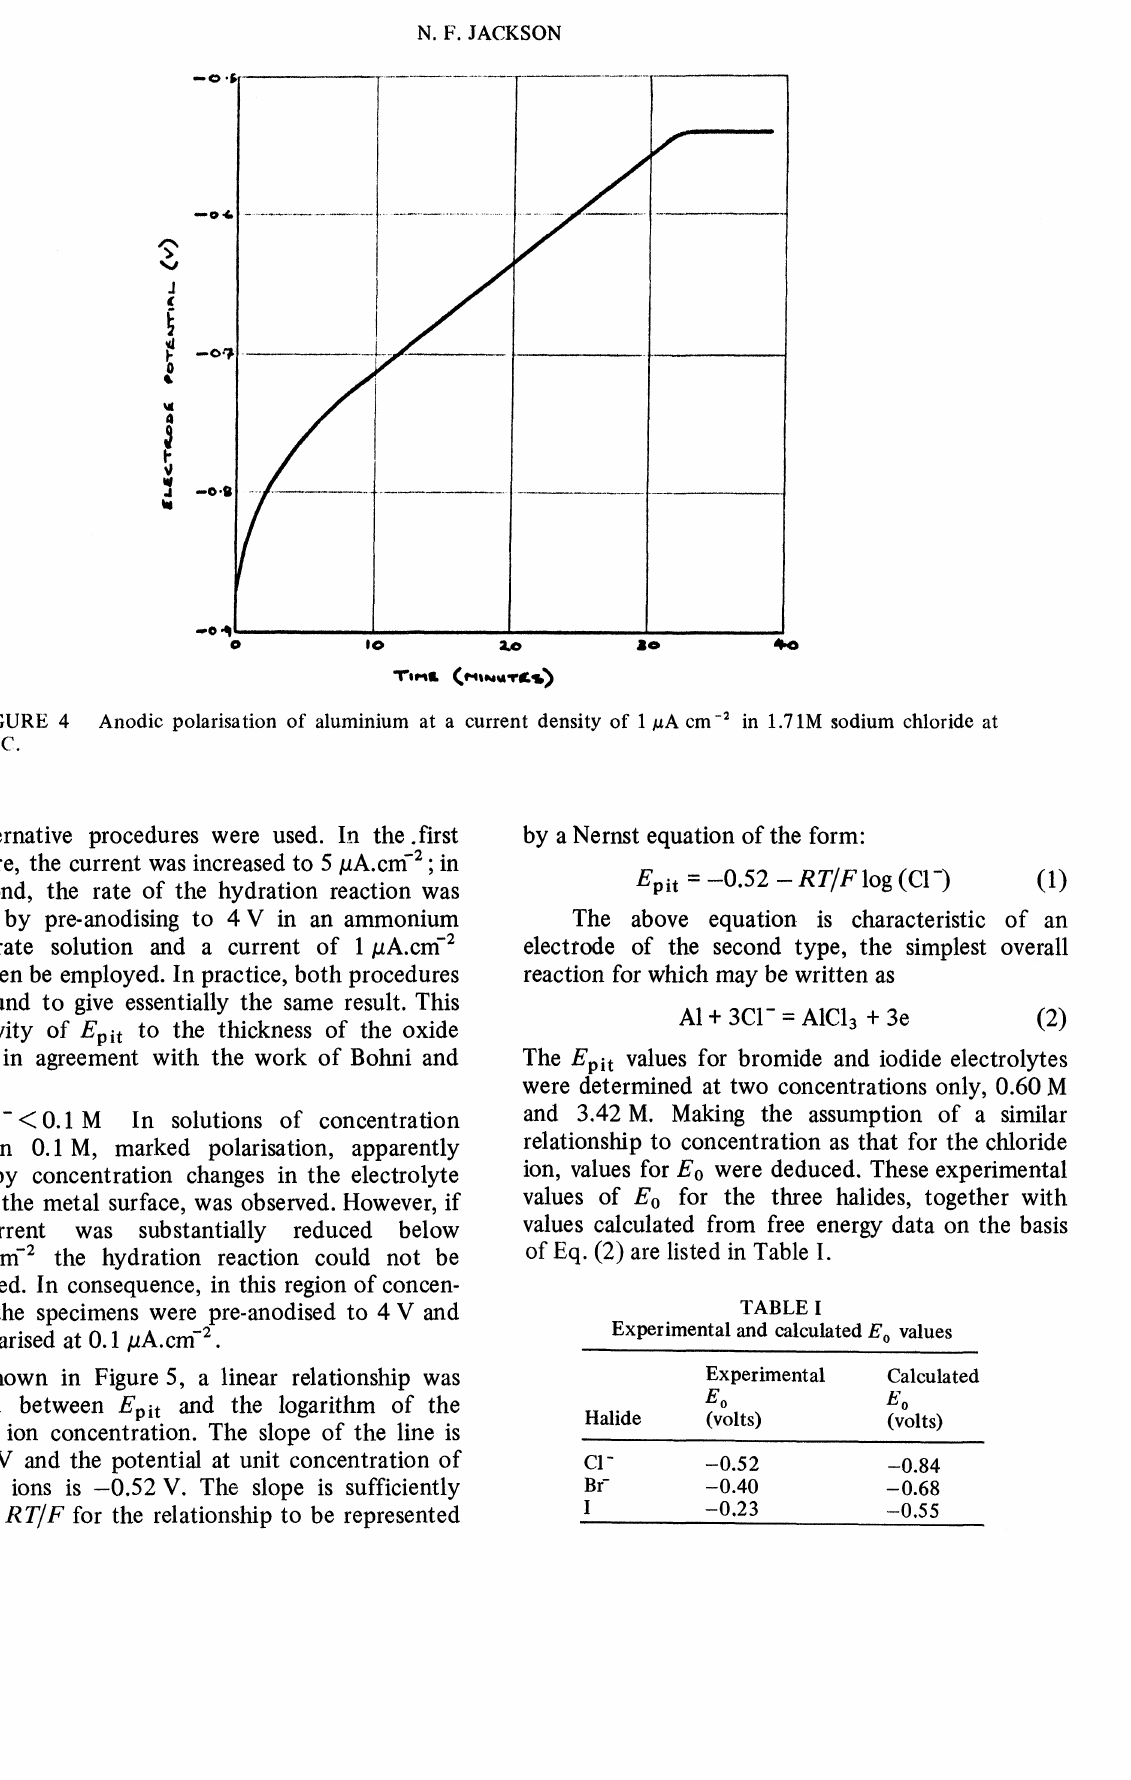
Experimental and calculated E values